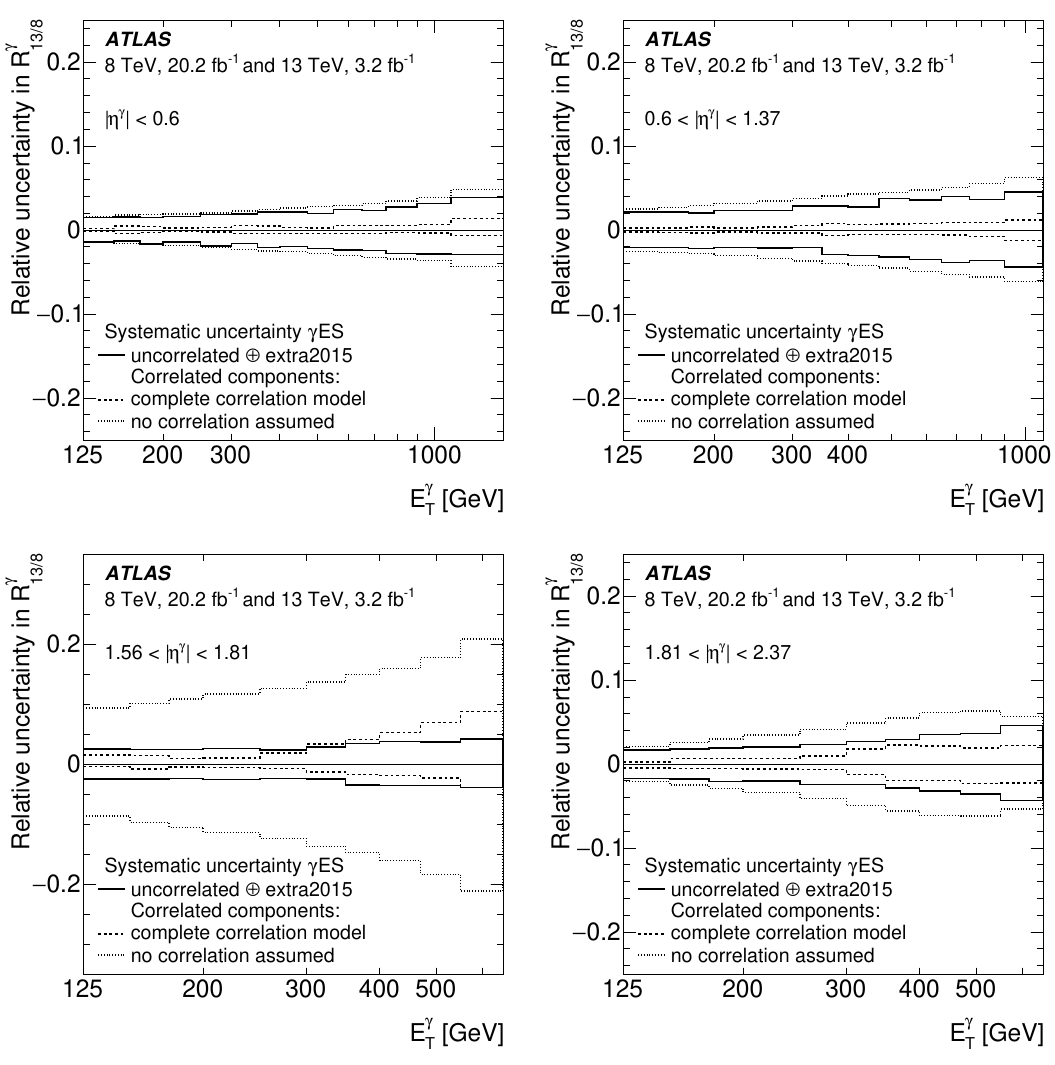
Figure 2 . Relative systematic uncertainty in R (cid:13) as a function of E (cid:13) for di(cid:11)erent (cid:17) (cid:13) regions due T 13 = 8 to the (cid:13) ES correlated components (dashed lines). For comparison, the results of considering the components as uncorrelated are also shown (dotted lines) to illustrate the reduction in the size of the systematic uncertainty when the proper treatment is applied. The relative uncertainty due to the uncorrelated components of the photon energy scale and the components speci(cid:12)c to 2015 is also shown (solid